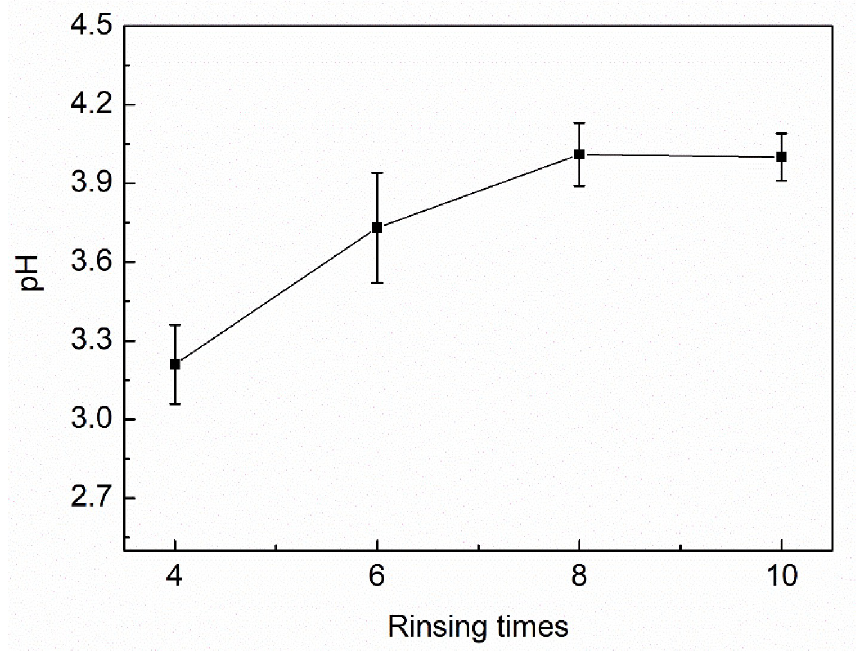
Fig 5. The pH of the humic acid sample after rinsing by distilled